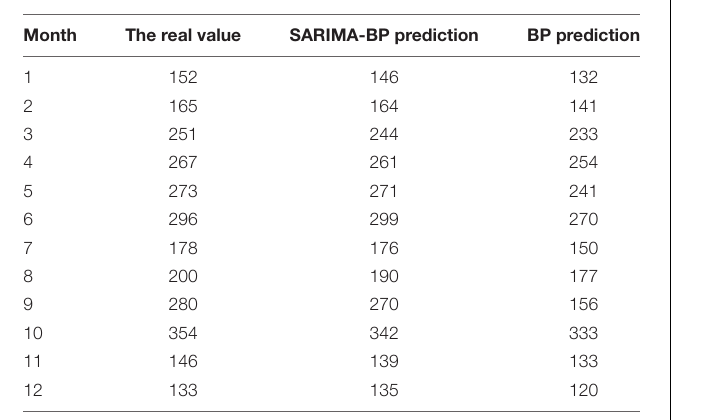
TABLE 1 | Comparison of the predictive and real posts.